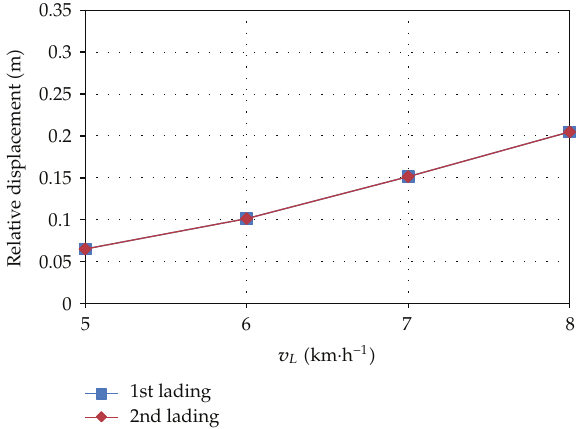
Figure 7: Results under m 1 (cid:10) 30t, m 2 (cid:10) 30t, μ 1 (cid:10) 0 . 4, and μ 2 (cid:10) 0 . 4.